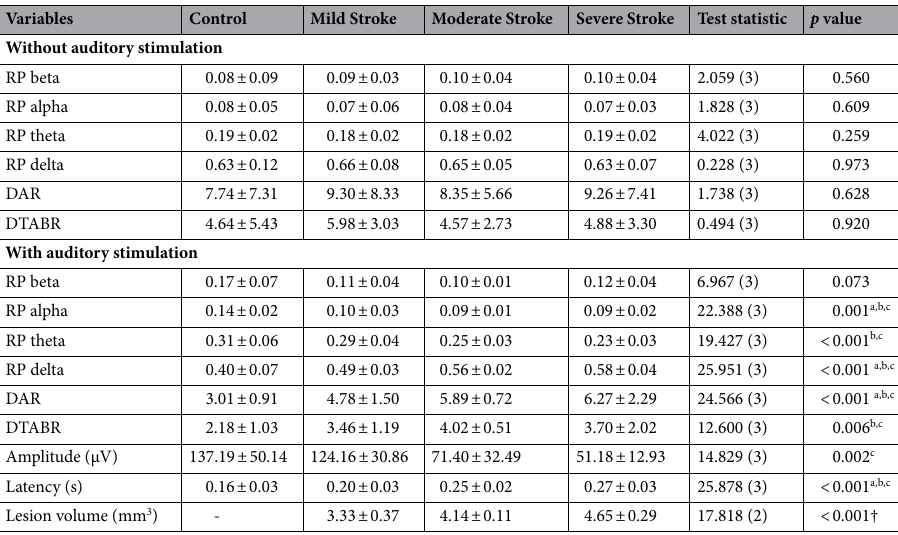
Table 1. Characteristics of EEG parameters and stroke lesion volume for the control group (n = 10), mild stroke group (n = 7), moderate stroke group (n = 7), and severe stroke group (n = 7). Data are presented as the median ± interquartile range. The values of test statistics are expressed as chi-square value and (df). The p values were derived using a Kruskal–Wallis test. a Represents statistical significance after Bonferroni correction between the control group and mild stroke group. b Represents statistical significance after Bonferroni correction between the control group and moderate stroke group. c Represents statistical significance after Bonferroni correction between the control group and severe stroke group. In addition, stroke lesion volume was significantly different between each